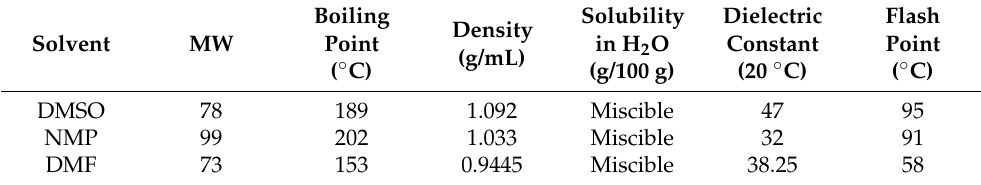
Table 2. Properties of different solvents.